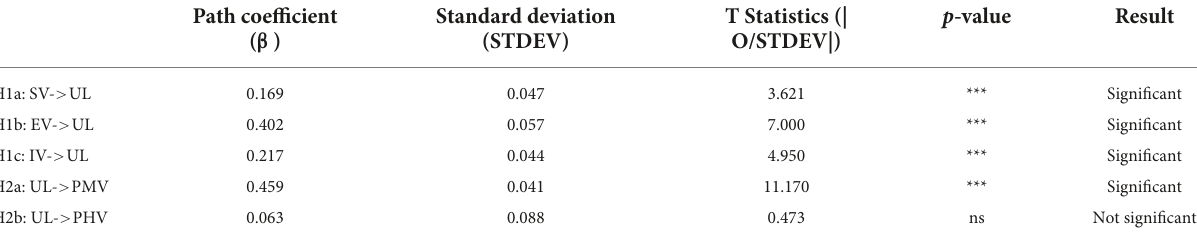
TABLE 4 Regression